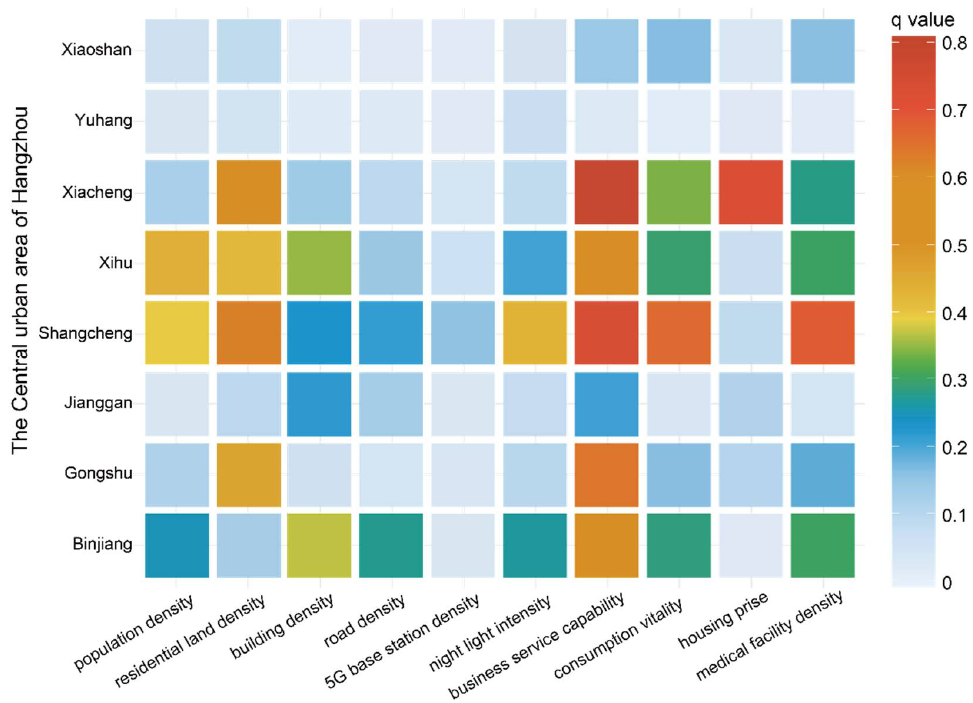
Figure 5. The factor detection results of regional differentiation of the unmanned aerial vehicle (UAV) logistics network at district-level in